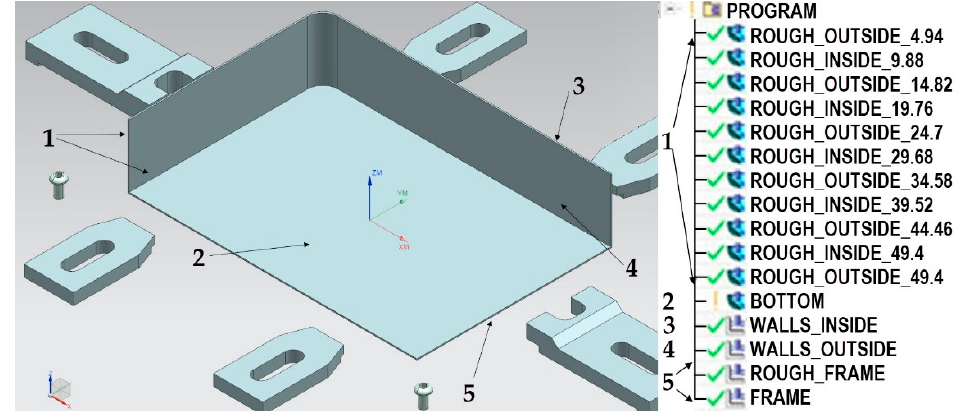
Figure 5. Stages of machining of the thin-walled element with walls arranged in a semi-open struc- ture.